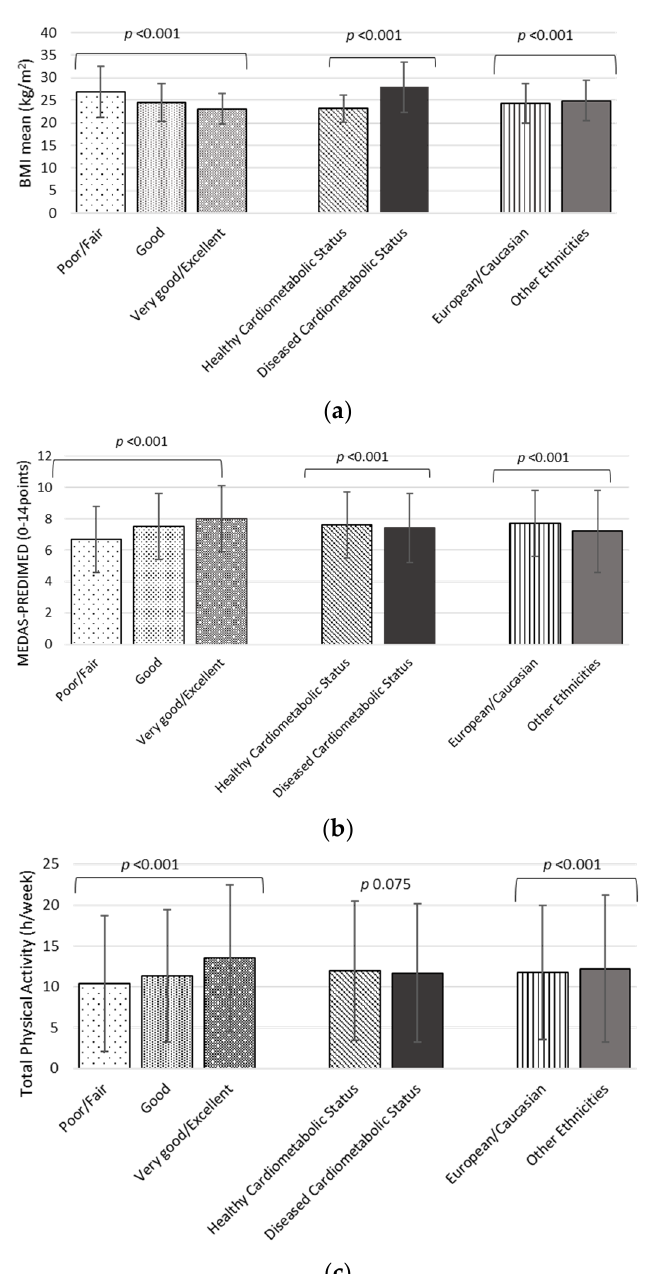
Figure 1. Descriptive Health Characteristics and Lifestyle Categorized by HRQoL, Cardiometabolic Health Status and Ethnicity of the participants of the study. ( a ) BMI mean Categorized by HRQoL, Cardiometabolic Health Status and Ethnicity; ( b ) Mediterranean Adherence Score (MEDAS)–PREDIMED Categorized by HRQoL, Cardiometabolic Health Status and Ethnicity; ( c ) Total Physical Activity Categorized by HRQoL, Cardiometabolic Health Status and Ethnicity.